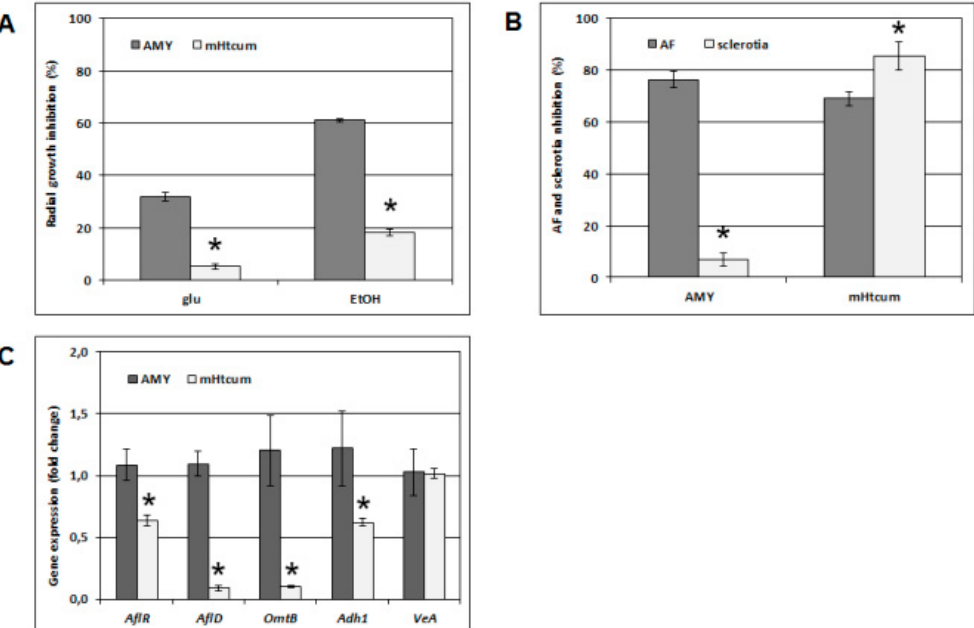
Figure 7. Comparison between mHtcum and antimycin effect on A. flavus . ( A ) Differential effect on growth under fermentable/non-fermentable conditions. Fungal growth was assessed as radial growth inhibition of mHtcum or AMY treated A. flavus colonies (50 μ M) with respect to the control (0.5% DMSO treated cultures). Statistically significant differences respect to AMY treatment are indicated (* p < 0.05). ( B ) Effect of mHtcum and AMY on aflatoxin production and sclerotia development. A. flavus conidia were inoculated either in CCM or CZ medium for the aflatoxin production and sclerotia development determination respectively (see Materials and Methods section for details). Media were amended with 50 μ M mHtcum or AMY, and 0.5% DMSO as control. Statistically significant differences with respect to AMY treatment are indicated (* p < 0.05). ( C ) Gene expression fold change of in response to mHtcum and AMY treatment (50 μ M). A. flavus conidia were incubated and cultivated in the identical cultural conditions used for aflatoxin determination. The 1.0 line represents the control (0.5% DMSO) expression level. Asterisk indicates the differences that were statistically significant (* p < 0.05).